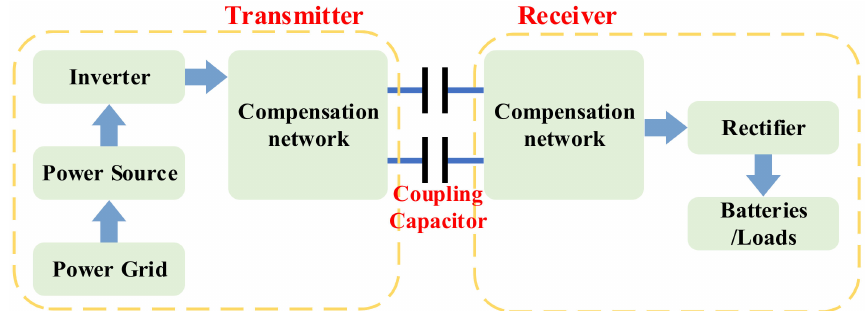
Figure 5. Components and fundamentals of the EC-WPT system.